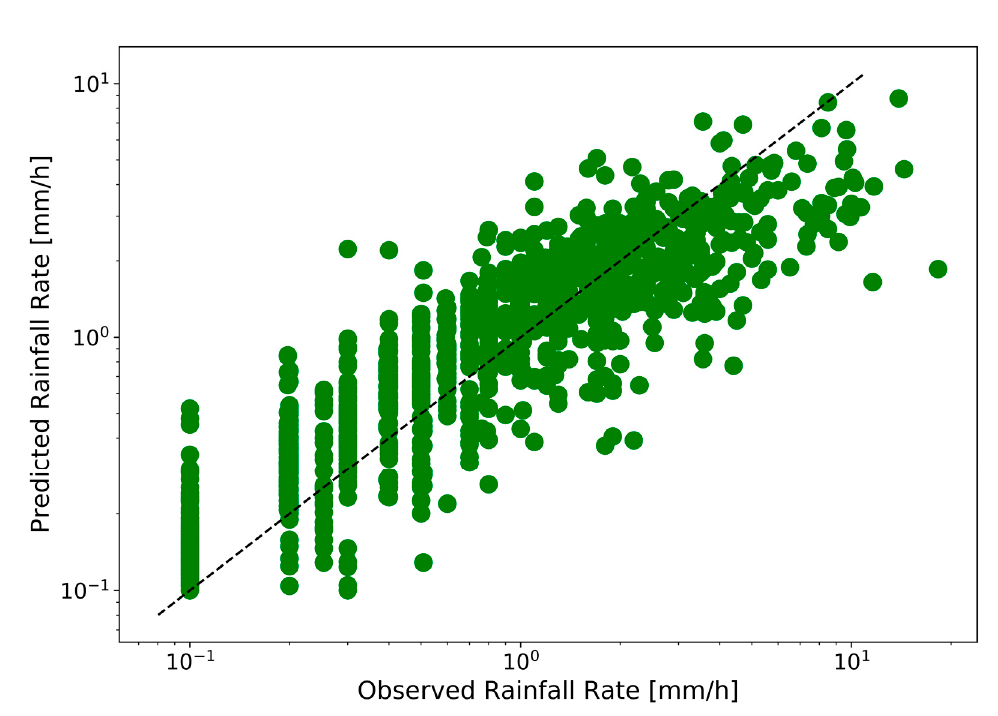
Figure 7. Correlation of observed and estimated hourly rainfall using QPE random forest model on the entire test dataset (15 independent events) is illustrated. The 1-1 line is show in black dotted.